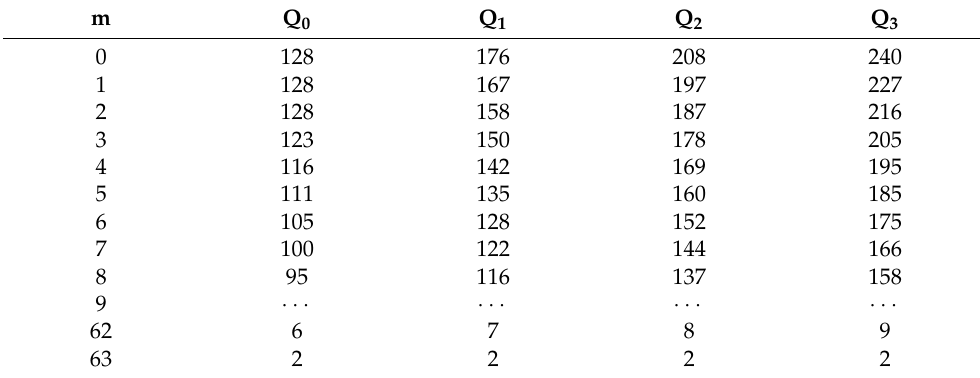
Table 2. M-coder RTAB (b =